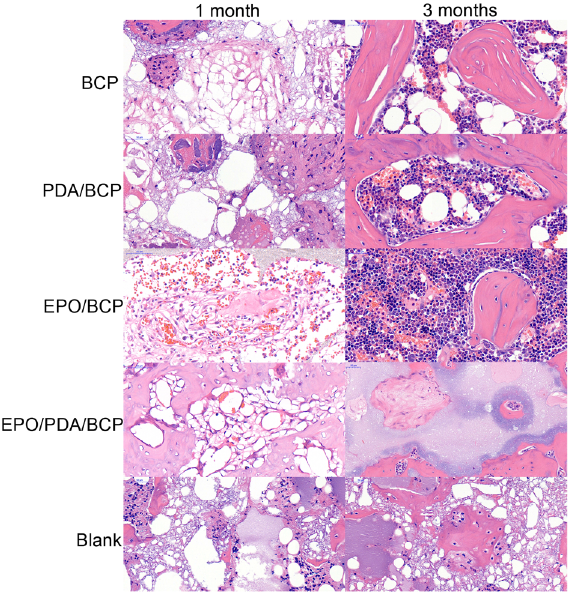
Fig. 9 HE staining of rat femoral defect repair tissue sections 1 and 3 months post